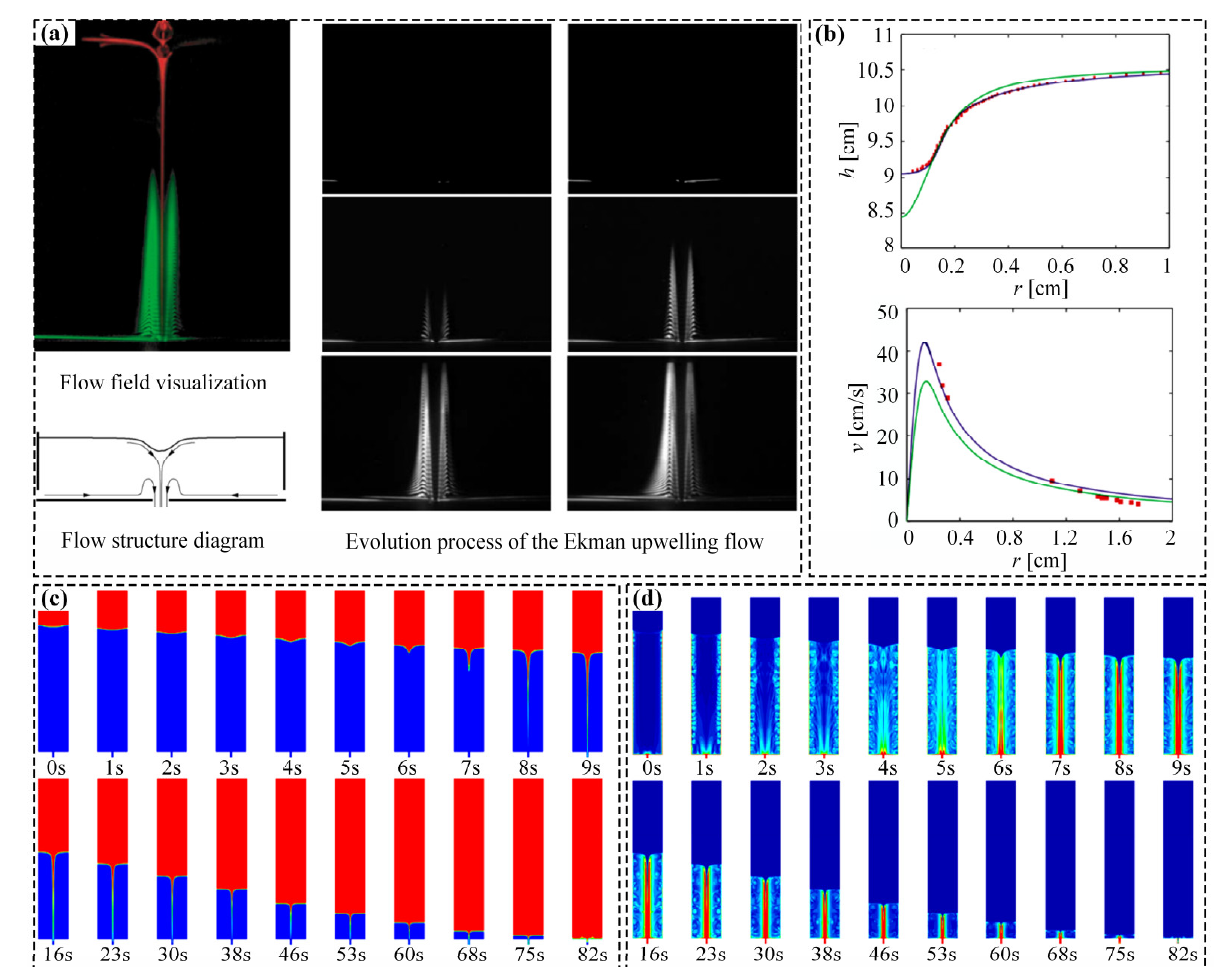
Figure 6. Ekman layer evolution characters of free sink vortex. ( a ) Laminar flow phenomenon. ( b ) Lundgren’s equations with surface tension and without surface tension. Reproduced with the permission of the Cambridge University Press. (Reprinted with permission from Ref. [68]. 2006, Cambridge University Press). ( c ) Generation and progression of the air core. ( d ) Progression of the vorticity distribution. Reproduced with the permission of Elsevier. (Reprinted with permission from Ref. [71]. 2011, Elsevier.)